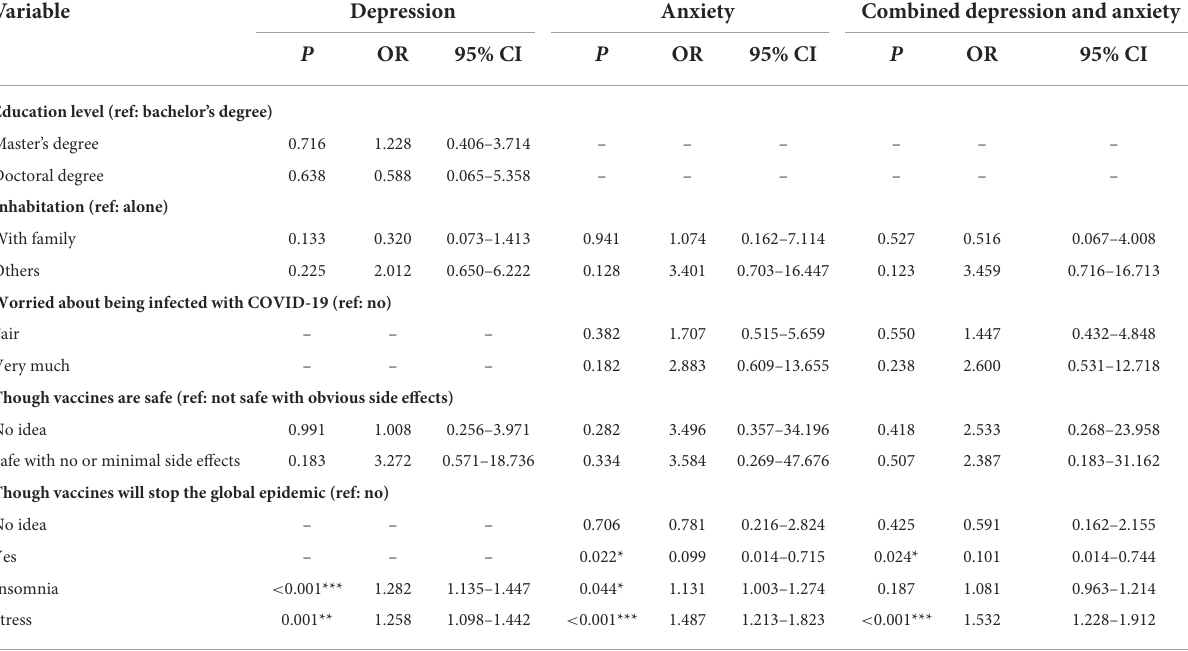
TABLE 2 The binary logistic regression analysis of depression, anxiety, and combined depression and anxiety in the study participants.